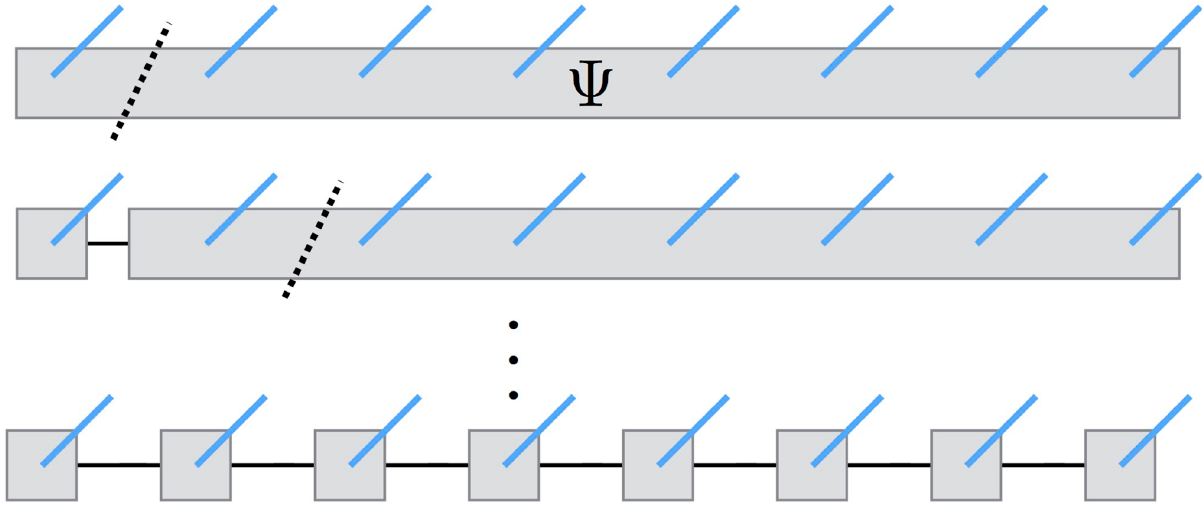
Fig 1. Decomposition of the multi-qubit wave-function tensor into the matrix-product state (MPS) tensor network, replacing a single node (tensor) having N (open) edges with N nodes (tensor factors) having at most three edges each.